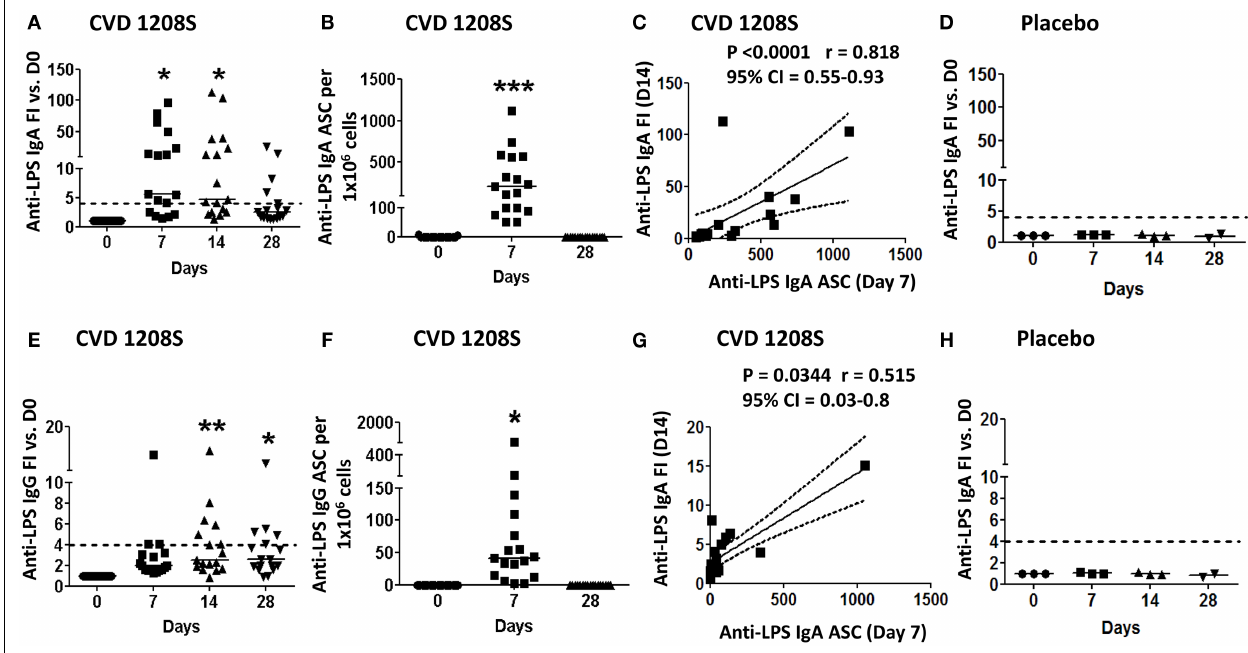
FIGURE 1 |Anti-LPS IgA and IgG immune responses to CVD 1208S . (A,E) Anti-LPS IgA and IgG serum levels before and at days 7, 14, and 28 after immunization. Seroconversion was defined as a ≥ 4-fold-increase (dotted line) in antigen-specific antibody titers compared to day 0. (B,F) ASC anti-LPS IgA and IgG (ELISpot) before and at days 7 and 28 after immunization. (C,G) Spearman’s correlation between anti-LPS IgA and IgG antibody titers